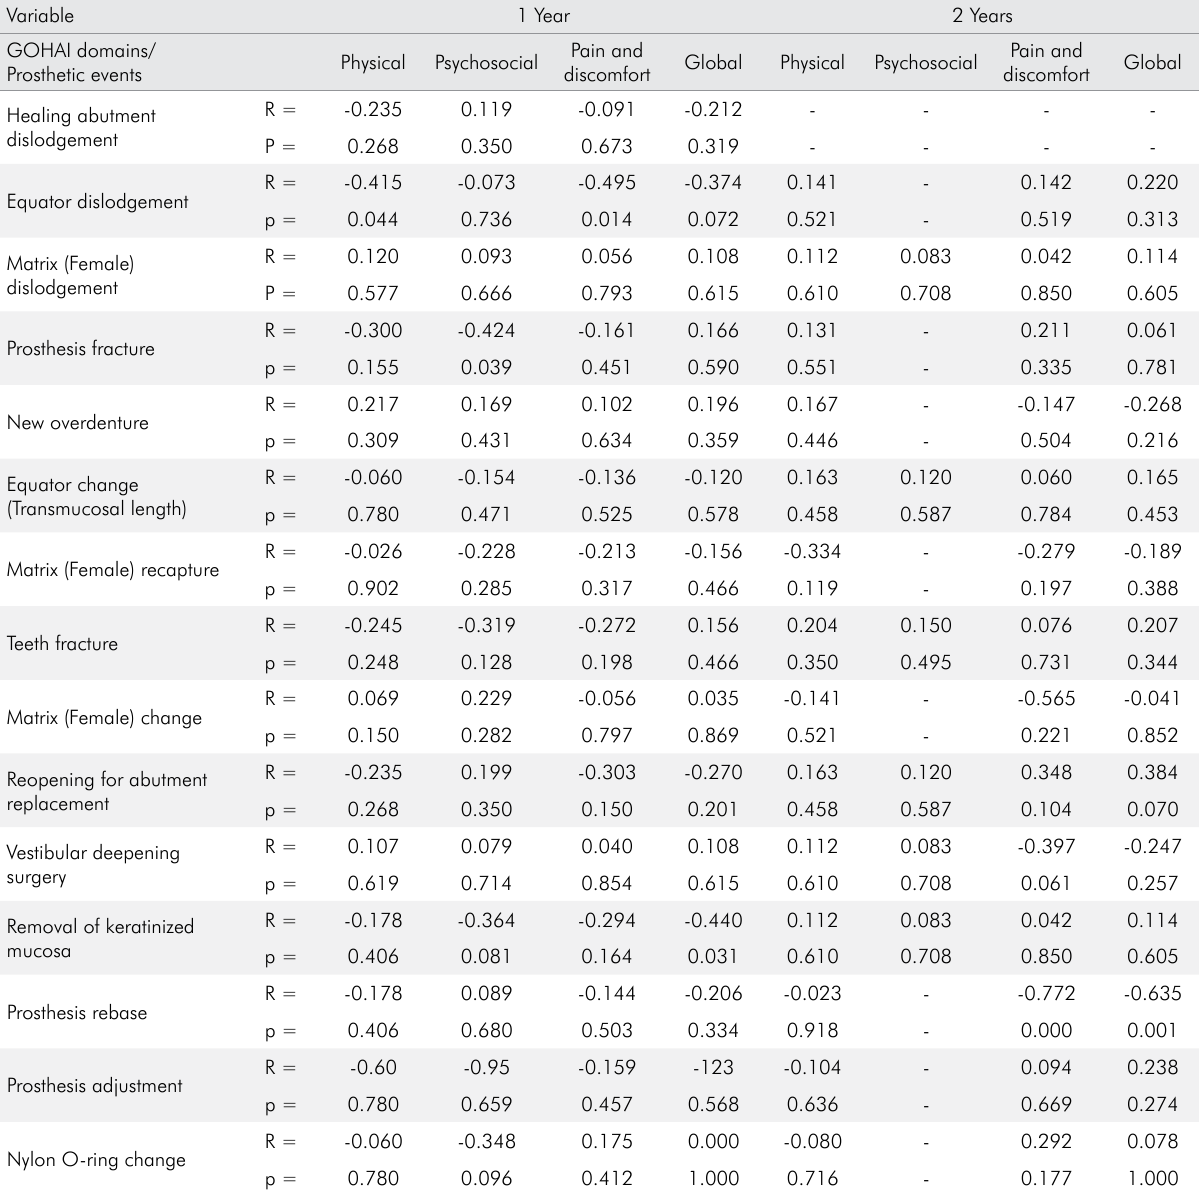
Table 4. Spearman correlation between the GOHAI questionnaire domains and prosthetic events after 1 and 2 years of MO loading.